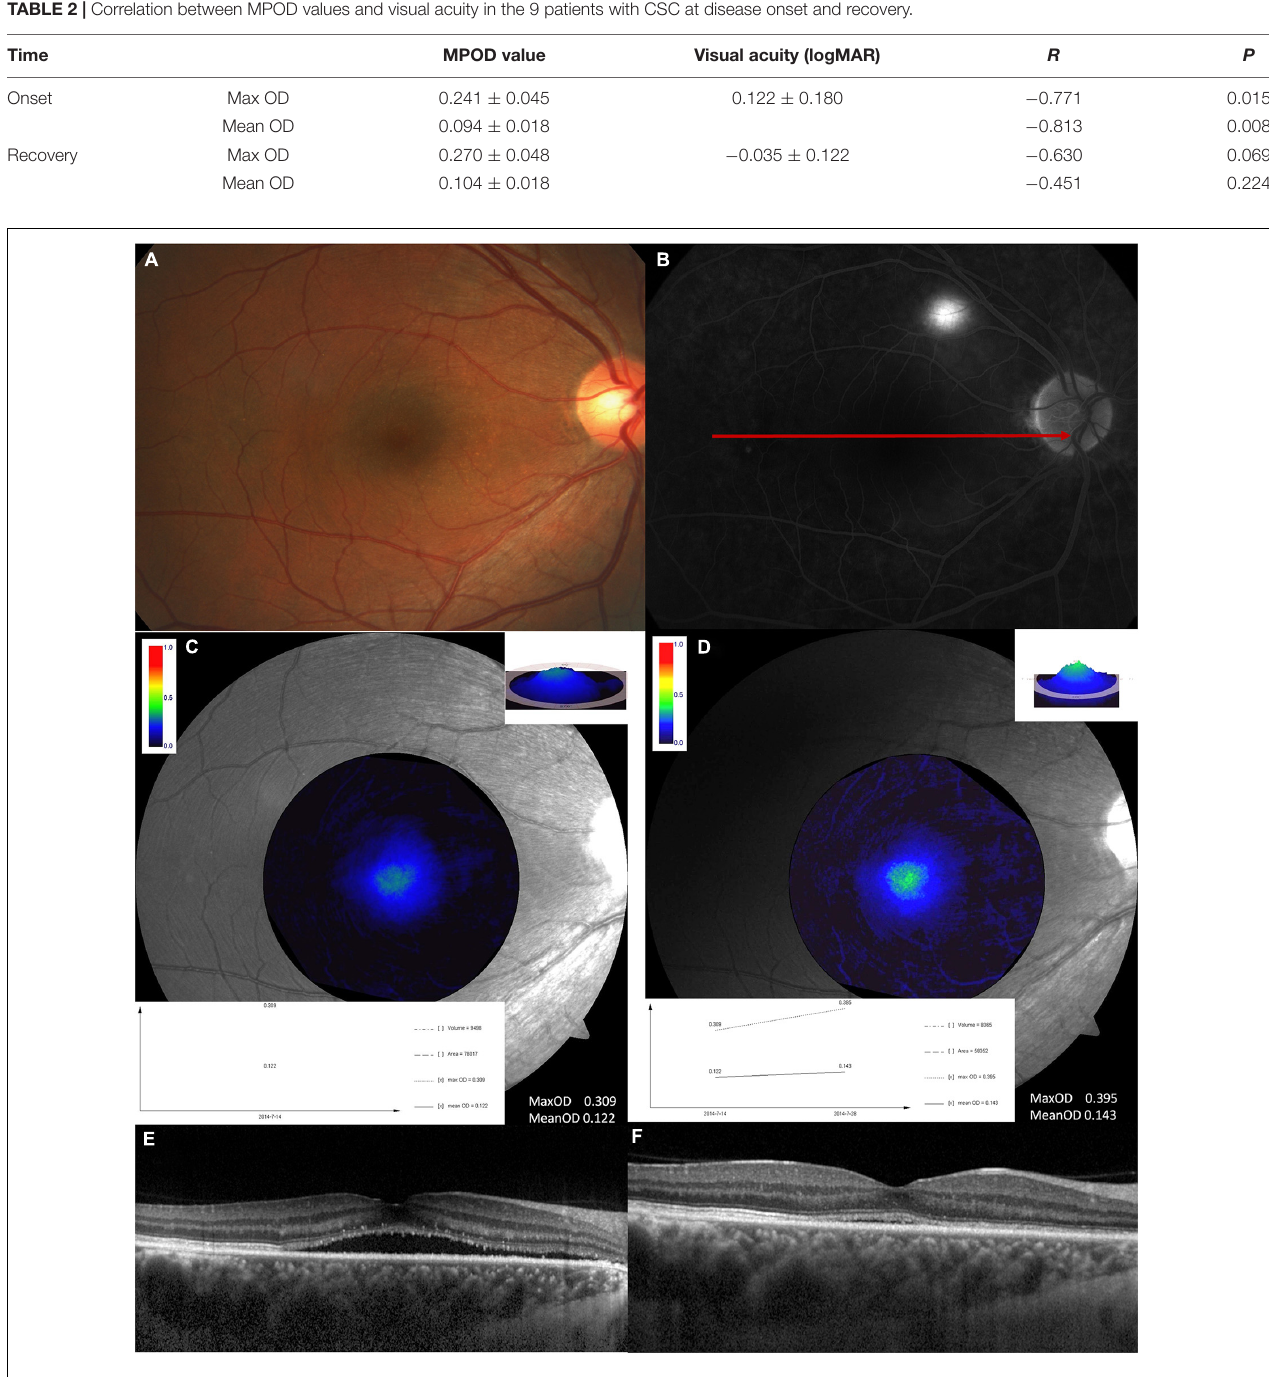
FIGURE 2 | A typical example showing MPOD changes at the disease onset and the recovery time. This is a 45-years-old male. (A) Fundus image and (B) fluorescence fundus angiography image at the disease onset. The second row is the MPOD value analyzed at disease onset (C) and recovery time (D) . Both max OD and mean OD increased at the recovery time compared with that at disease onset. The exact MPOD value is marked in the picture. The third row shows the optical coherence tomography findings at disease onset (E) and the recovery time (F)